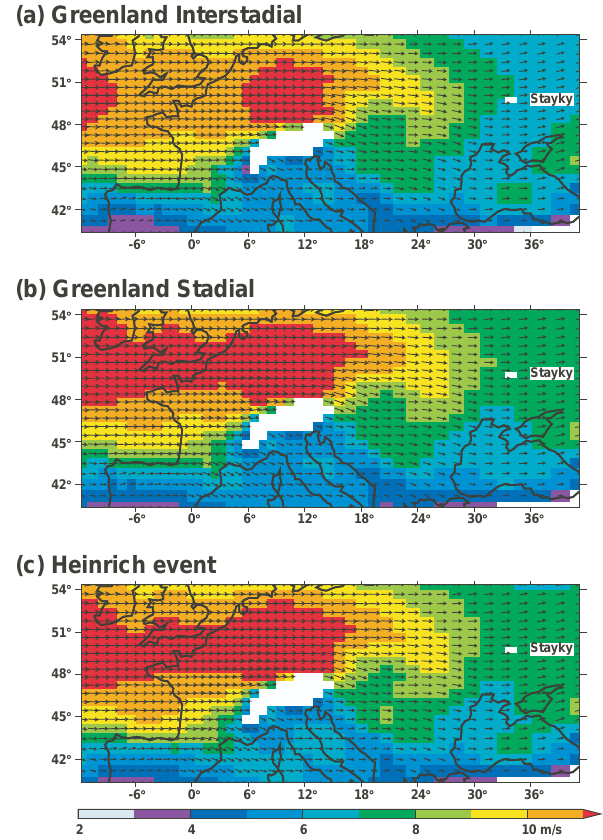
Fig. 5. Average wind field at 850hPa in Europe at temperate lati- tudes for three simulated climate states associated with (a) a Green- land Interstadial, (b) a Greenland Stadial and a Heinrich event (c) (after Sima et al., 2009). The Stayky location is marked.